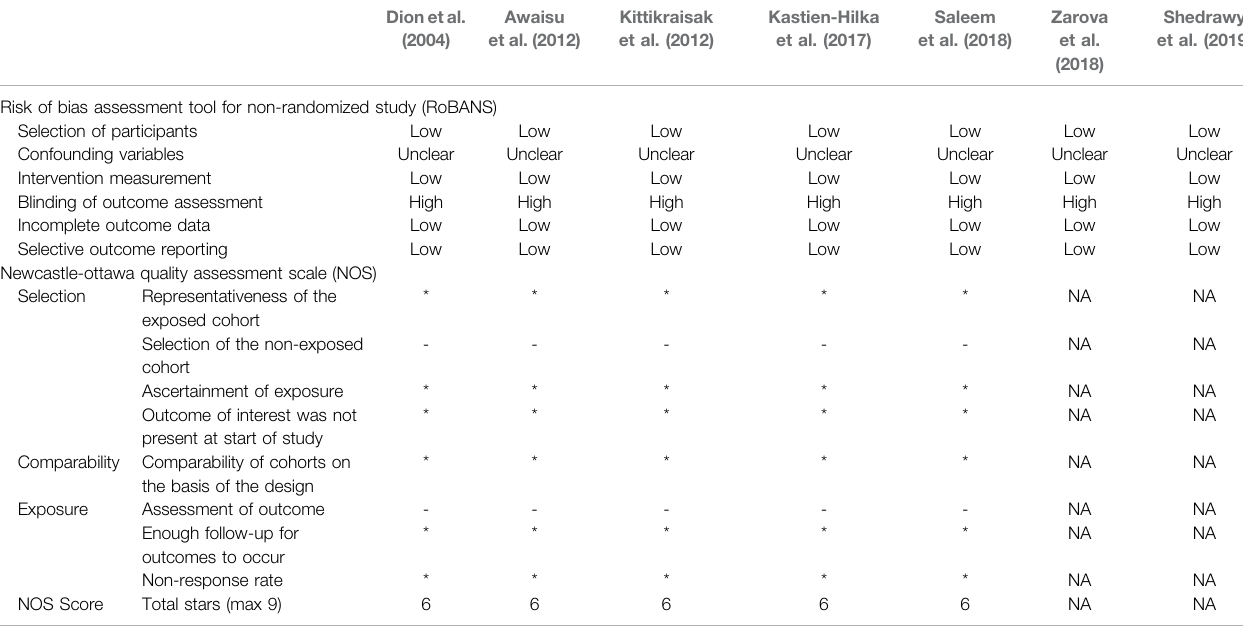
TABLE 2 | Risk of bias assessment for selected studies.